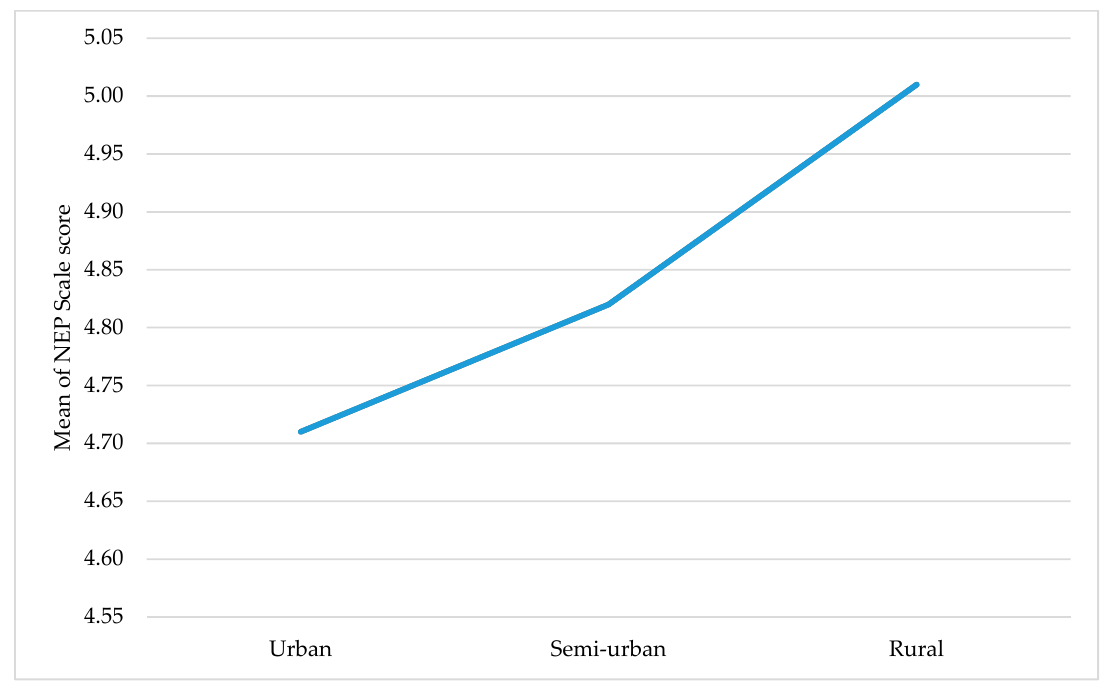
Figure 5. Means plot for the one-way ANOVA between the New Environmental Paradigm scale (NEP) mean score and the area of residence.